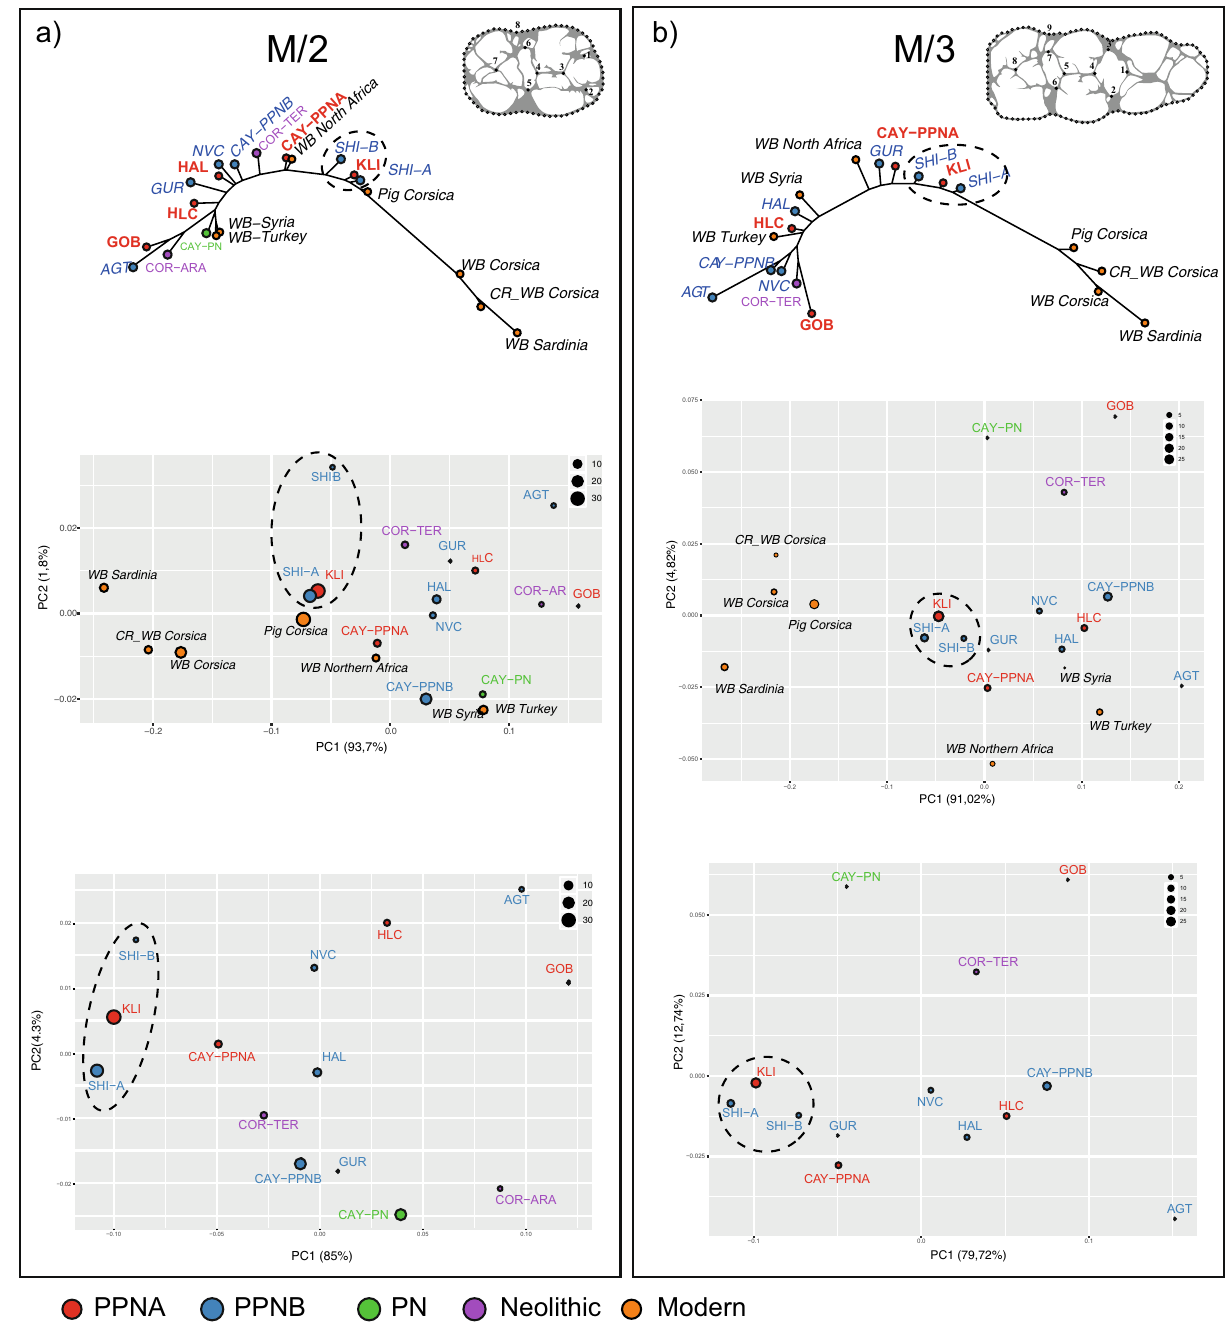
Figure 6. Patterns of similarities and dissimilarities in mean dental forms of M/2 (a) and M/3 (b) among modern and archaeological Mediterranean Sus scrofa displayed with an unrooted neighbour-joining tree (above) and a PCA (middle and bottom). PCA on archaeological mean forms only are displayed in the bottom